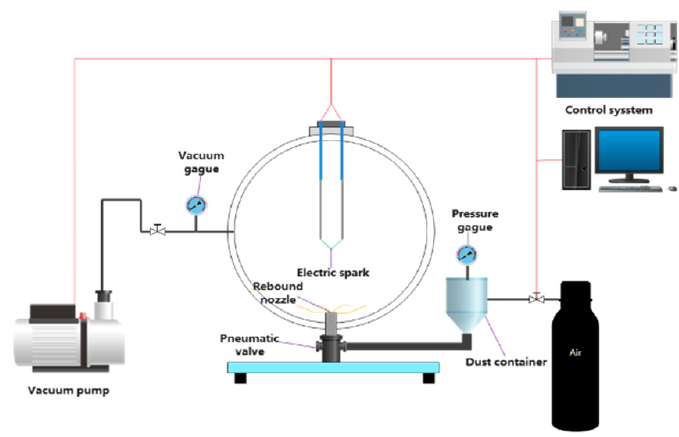
Figure 2. Schematic diagram of 20 L apparatus [24].